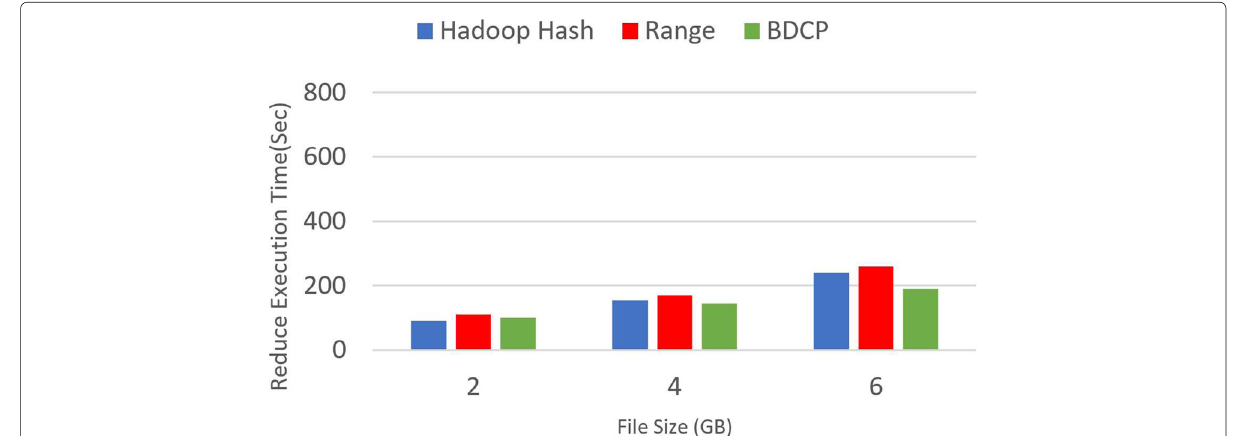
Fig. 11 Sort job on files of sizes, 2, 4, and 6 GB. Skew degree is